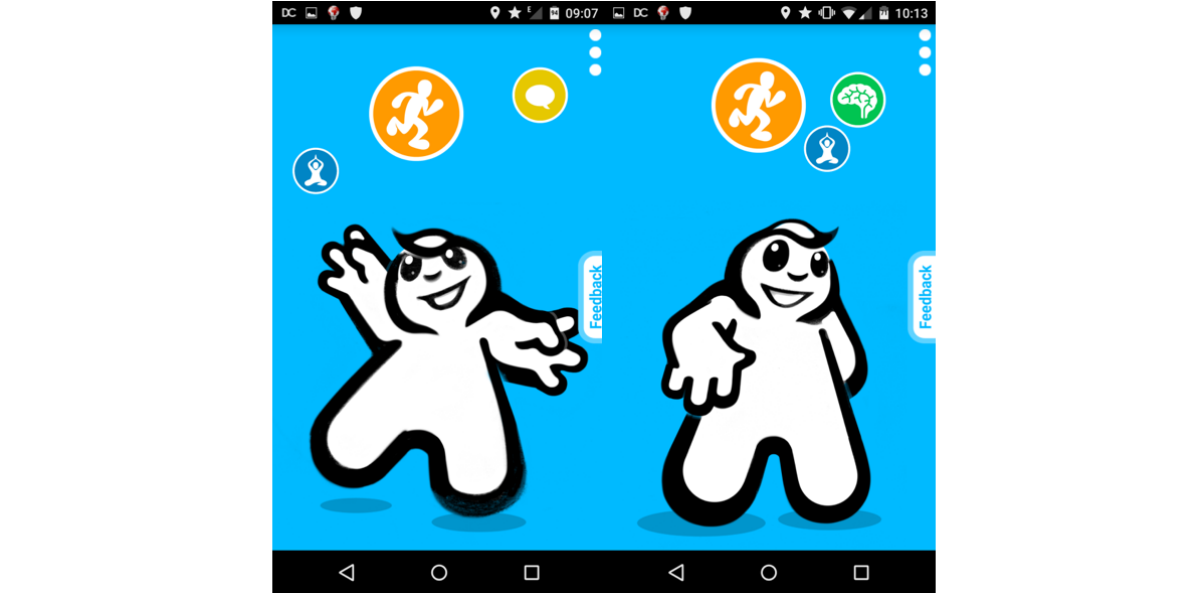
Figure 3. Example recommender results with physical activity baskets showing the highest score (orange circle) compared with social activity (yellow), mindfulness (green), and relaxation